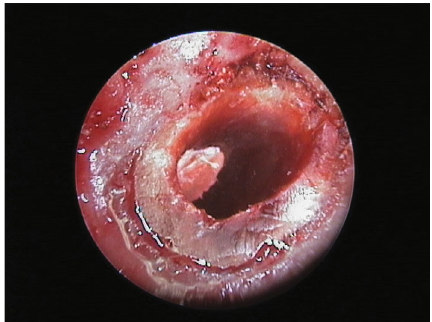
Figure 15: Endoscopic view of 2.1 after fi lling of the retrograde cavity with MTA.